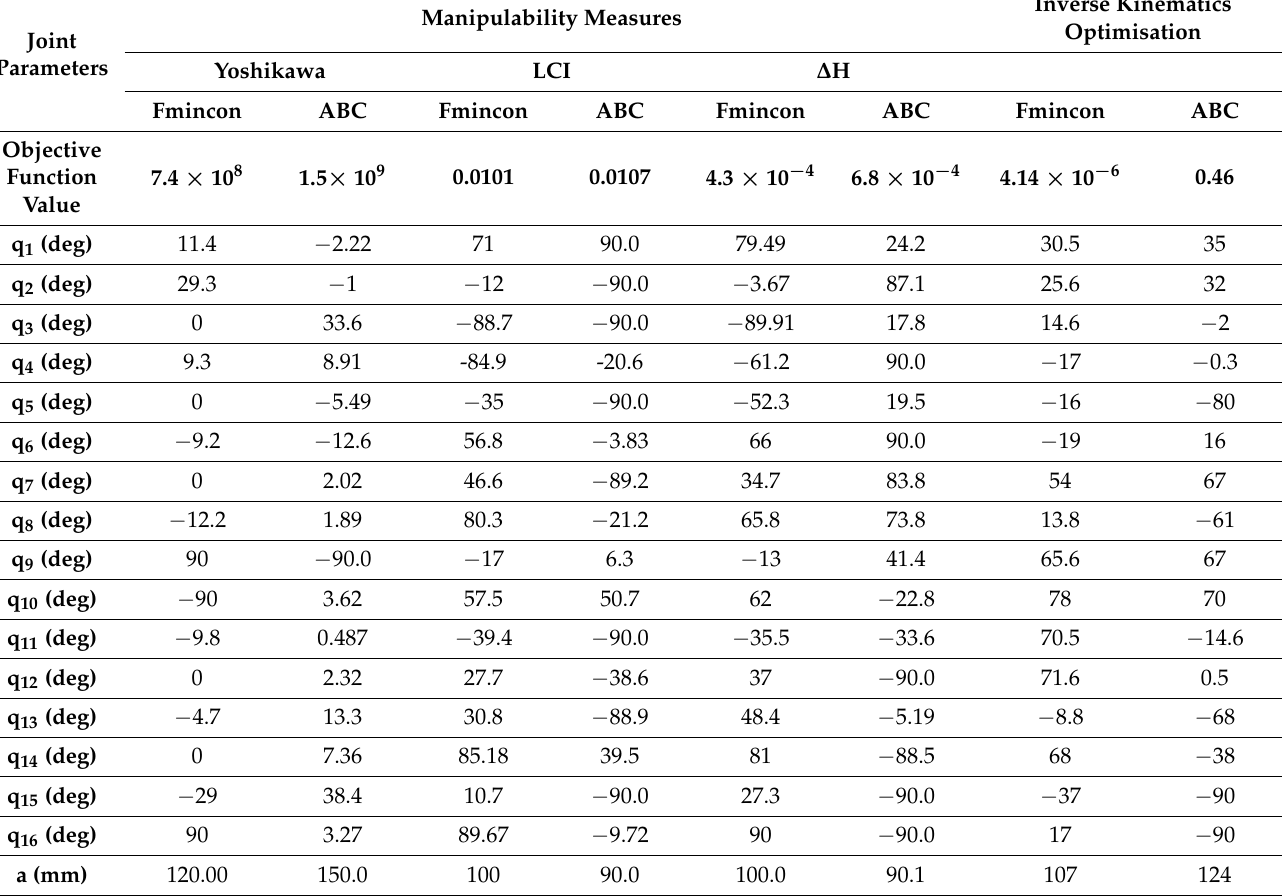
Figure 10. Objective function values ( left ), and the corresponding optimised joint parameters ( right ) for the best objective function value obtained by ABC for the IK optimisations. All the optimised values of parameters obtained by the different objective functions used in this study are summarised in Table 2. Table 2. The optimal joint parameters corresponding to the best objective functions.